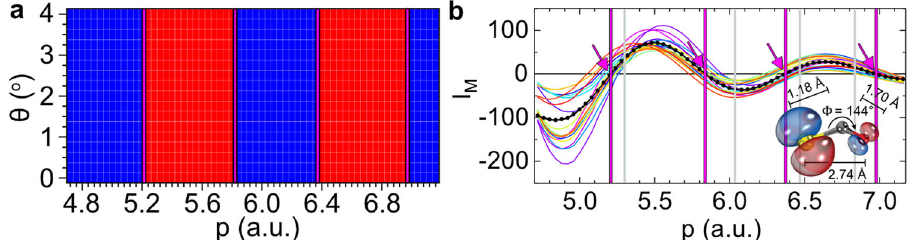
Fig. 3 ZCP-LIED retrieval of OCS + structure. a Reconstructed 2D map analogous to that of Fig. 2b. This 2D map was retrieved following the best fi t between the experimental data (Fig. 2b) and the corresponding 2D map calculated using the independent atom model (IAM). b Molecular interference signal, I M , extracted from experimental data (coloured lines) and the corresponding theoretically calculated distribution (black circled line) that best fi ts the measured data. A schematic of the reconstructed molecular structure is shown. The zero-crossing points (ZCPs) are indicated by magenta vertical solid lines and arrows. The four reconstructed ZCPs (magenta vertical lines; 5.21, 5.82, 6.37, 6.97 a.u.) from the equilibrium best- fi t theoretical data that best match the ZCPs of the experimental data over the 17 scattering angles using the IAM, and correspond to a bent and asymmetrically stretched OCS + structure. The equilibrium neutral ground-state OCS (grey vertical solid lines; 5.30, 6.03, 6.47, 6.84a.u.) are shown for comparison. Experimental data are shown for θ = 0.0 – 4.0° in steps of Δ θ = 0.25°.